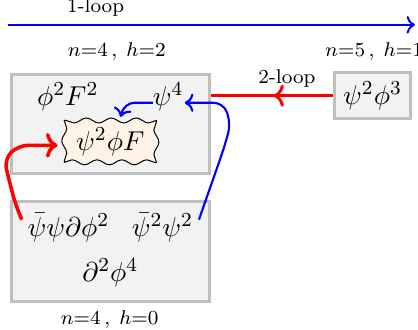
Figure 1 . Structure of the RG mixings from dimension-six operators into LFV dipoles. One-loop RG mixing can only proceed from left to right, generating mixing between operators belonging to different helicity boxes (shown in grey), and within operators belonging to the same helicity box. One-loop mixing from the category ( n, h ) = (4 , 0) into (4 , 2) is forbidden by spurious SUSY [10] or helicity [11] selection rules, except for the non-holomorphic contribution proportional to y u y d or y u y e , which mixes the ψ 4 and ¯ ψ 2 ψ 2 four-fermion operators at one loop. In blue and red we